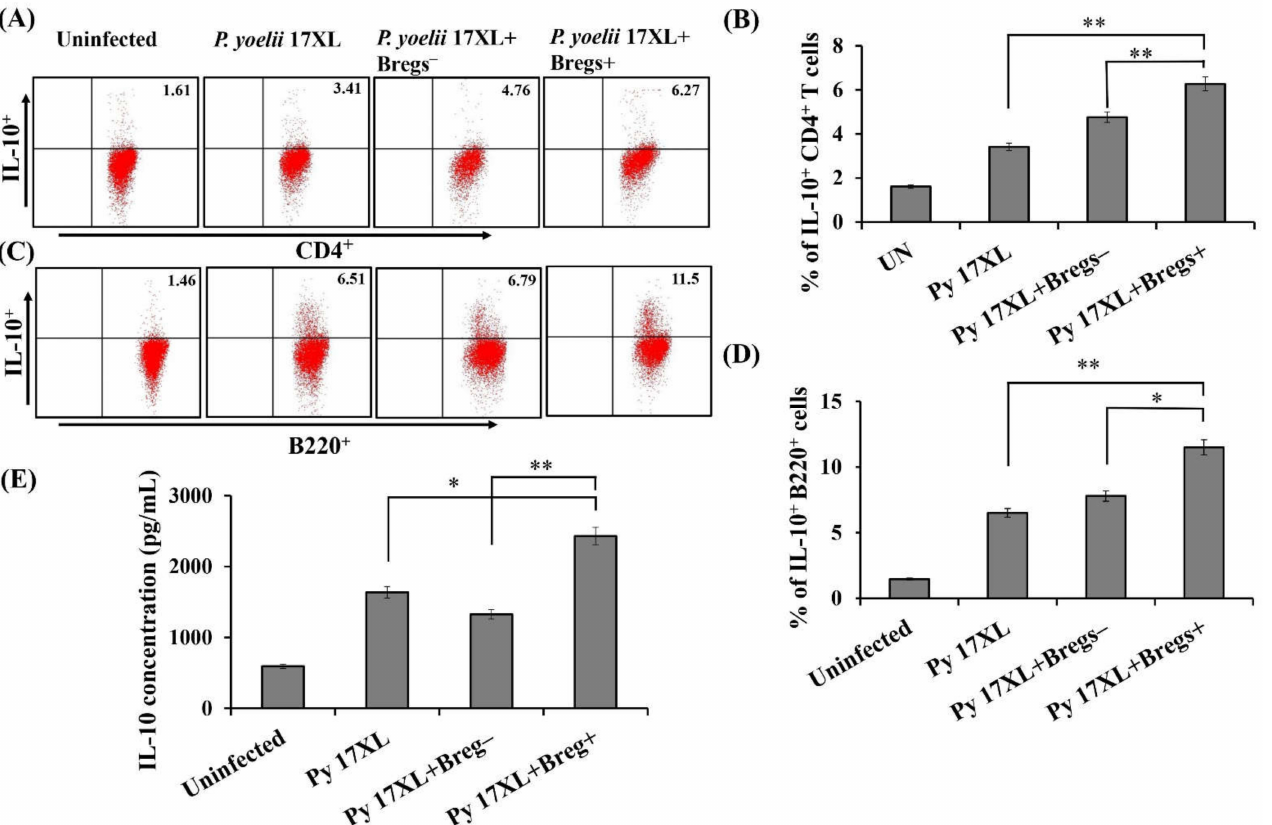
Figure 6. Adoptive transfer of regulatory B cells and its effect on anti-inflammatory immune re- sponse: Infusion of regulatory B cells modulates the immune response by altering cytokine profiles. Splenocytes were harvested at day 9 post-infection from Py 17XL infected mice either infused with Breg + or Breg − cells. Splenocytes were stained with IL-10 specific antibody along with anti-B220 and anti-CD4 antibodies. ( A , C ) Flow cytometric analysis shows the expression of IL-10 cytokine on CD4 + T-cells and B220 + B cells in uninfected, P. yoelii 17XL infected mice and P. yoelii 17XL infected mice either infused with Breg + cells or Breg − cells ( n = 12). ( B , D ) Bar graph representing the percentage of IL-10 on T cells and B cells. ( E ) Serum samples were collected after 9th day of adoptive transfer of regulatory B cells. IL-10 expression was measured by Luminex micro-bead array system in Py 17 XL infected mice infused with Breg + cells or the Breg − cells. Data are shown as mean ± SD of 9 mice pooled from three independent experiments statistical significance was determined by unpaired two-tailed Student’s t -test (* p < 0.05, ** p <